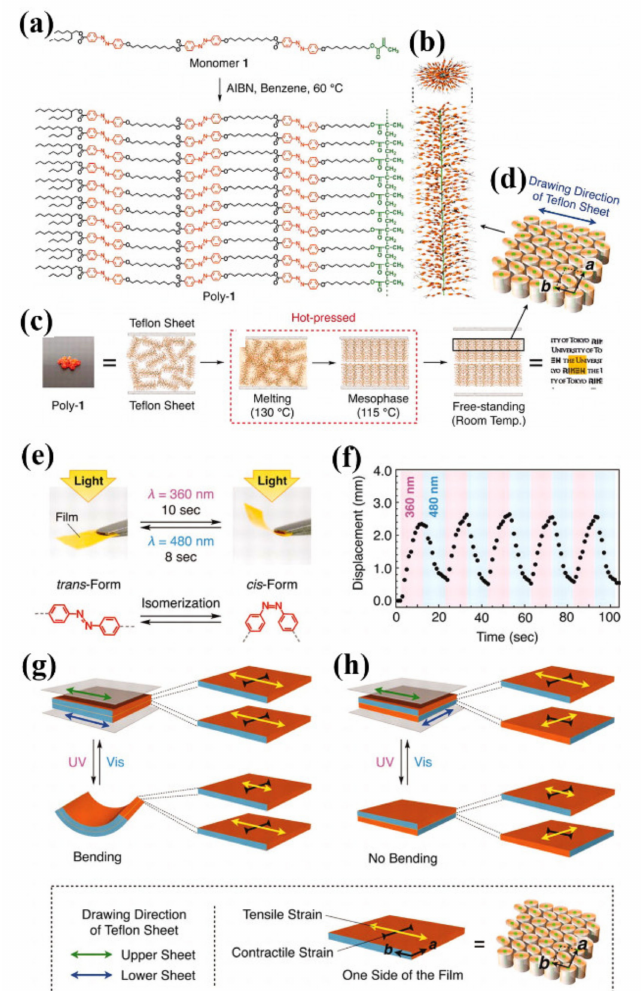
Figure 7. ( a ) Chemical structure and synthetic route of poly-1. ( b ) Schematic illustration of poly-1 adopting a cylindrical shape. ( c ) Schematic illustrations of the procedure for hot-pressing of poly-1 with uniaxially stretched Teflon sheets, together with those of plausible molecular events upon hotpressing. ( d ) Schematic illustration of the molecular arrangement in a hot-pressed film of poly-1. Blue arrow denotes the drawing direction of the Teflon sheet for hot-pressing. ( e – h ) Photomechanical responses of hot-pressed films of poly-1 prepared with parallel and orthogonally arranged Teflon sheets: ( e ) photographs of a hot-pressed film (5 mm × 6 mm × 10 µ m) prepared with parallel- arranged Teflon sheets before (left) and after (right) exposure to UV light ( λ = 360 ± 2 nm). The bent film recovered the initial flat shape upon exposure to visible light ( λ = 480 ± 2 nm); ( f ) time-dependent change in displacement of the free edge of a hot-pressed film prepared with parallel-arranged Teflon sheets upon alternating irradiation with UV and visible lights; ( g , h ) schematic illustrations of tensile and contractile strains generated on one side of the films prepared with parallel ( g ) and orthogonally ( h ) arranged Teflon sheets. Reprinted with permission from Reference [55]. Copyright 2010 The American Association for the Advancement of